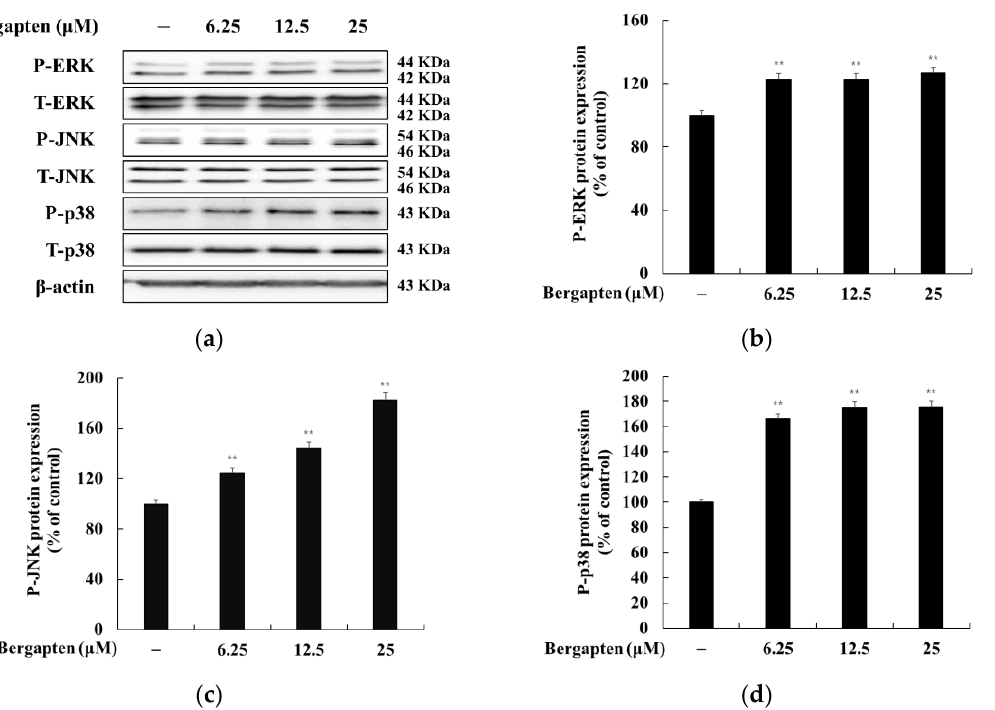
Figure 9. Effects of bergapten on the phosphorylation level of MAPKs in B16F10 melanoma cells. The cells were treated with bergapten (6.25, 12.5, and 25 μM) for 4 h. ( a ) Western blotting results and protein expression of ( b ) P-ERK/T-ERK, ( c ) P-JNK/T-JNK, and ( d ) P-p38/T-p38. β -actin was used as a loading control. The results are presented as the mean ± SD of three independent measurements using Image J. ** p < 0.01 vs. the untreated